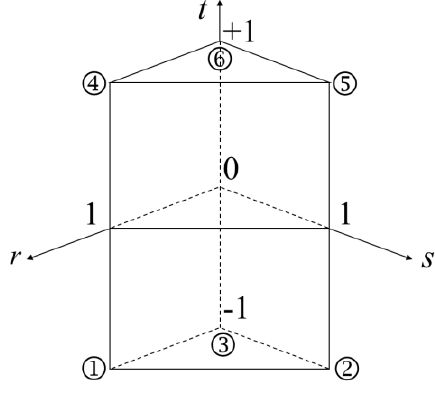
Figure 1. Straight triangular reference prism showing the vertex